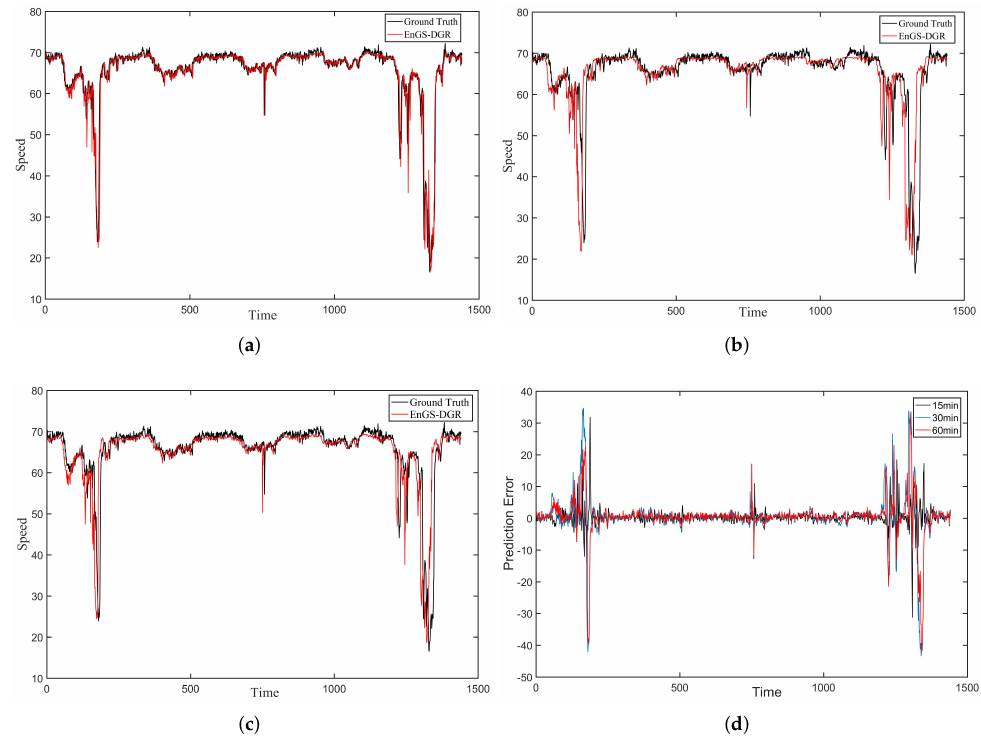
Figure 8. Forecasting results for PEMS-BAY dataset. ( a ) The comparison curves under 15 min forecasting interval. ( b ) The comparison curves under 30 min forecasting interval. ( c ) The comparison curves under 60 min forecasting interval. ( d ) The curves of forecasting